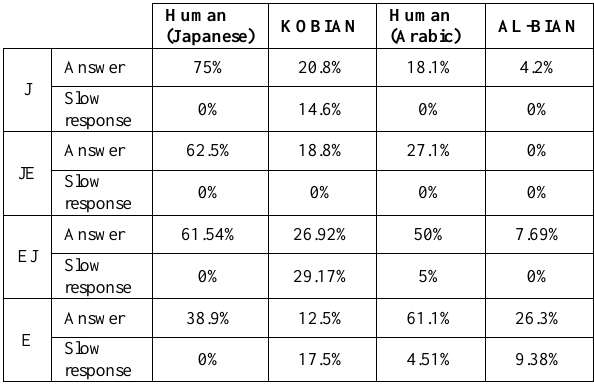
Table 2. Differences in Perceived Safety between the preliminary assessment on humanoid robots (“Pre”) and after interacting with the two robots.